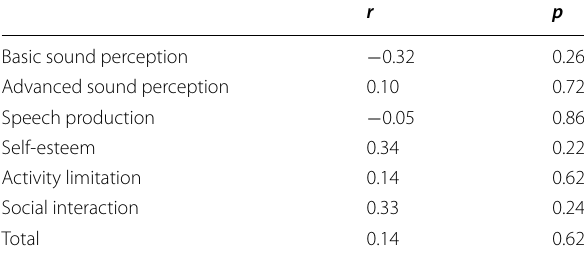
Table 4 Pearson correlation coefficient correlation between aided PTA threshold and NCIQ-Arabic version subdomains, showing no statistically significant correlation